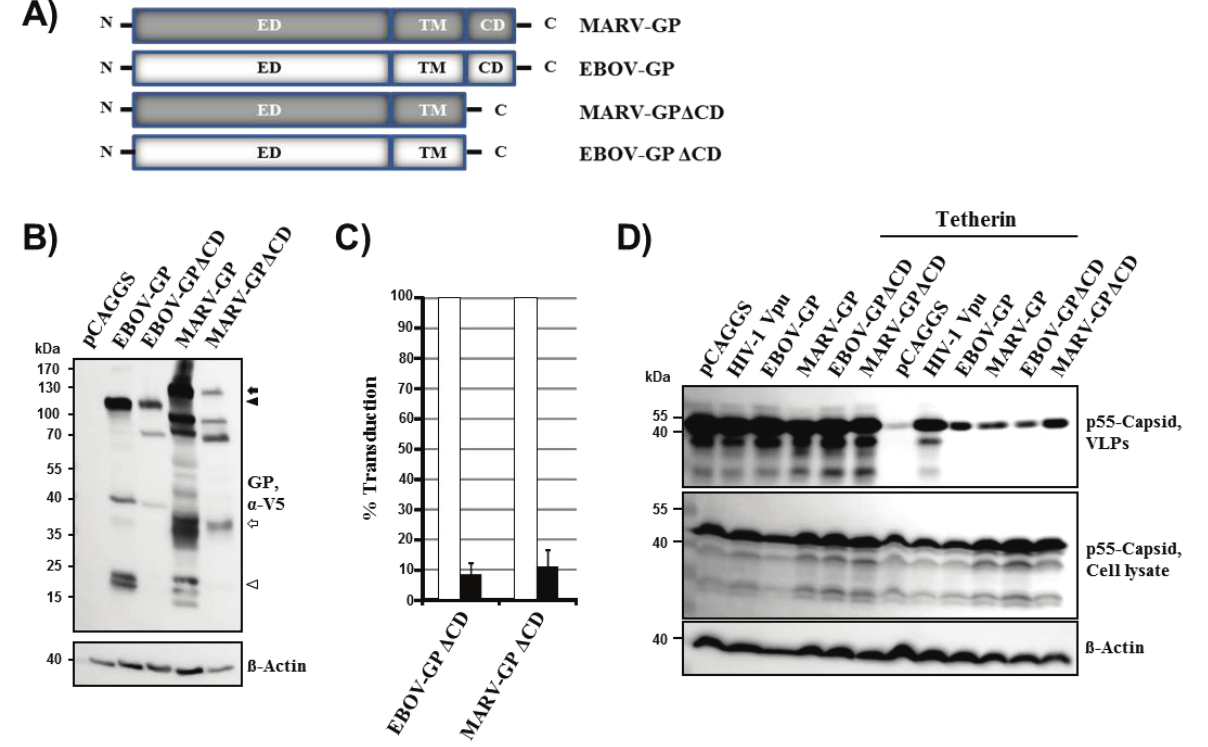
Figure 2. The cytoplasmic tail of filoviral glycoproteins is dispensable for tetherin antagonism. ( A ) Schematic representation of GP mutants analyzed. ED, extracellular domain; TM, transmembrane domain; CD, cytoplasmic domain. ( B ) The indicated glycoproteins harboring a C-terminal V5 antigenic tag were transiently expressed in 293T cells and expression analyzed by Western blot (upper panel), as described for Figure 1A. Expression of β -actin in cell lysates was determined as loading control (lower panel). Similar results were obtained in two separate experiments. Bands corresponding to glycoprotein precursors and their mature, transmembrane units are marked as described for Figure 1A. ( C ) Transduction of target cells by wt and mutant GPs was determined as described for Figure 1B. The average ± standard error of the mean (SEM) of at least three separate experiments is shown. Signals measured for wt GPs were set as 100%. ( D ) Tetherin antagonism by filoviral glycoproteins lacking the cytoplasmic domain was analyzed as described for Figure 1C. The results were confirmed in three separate